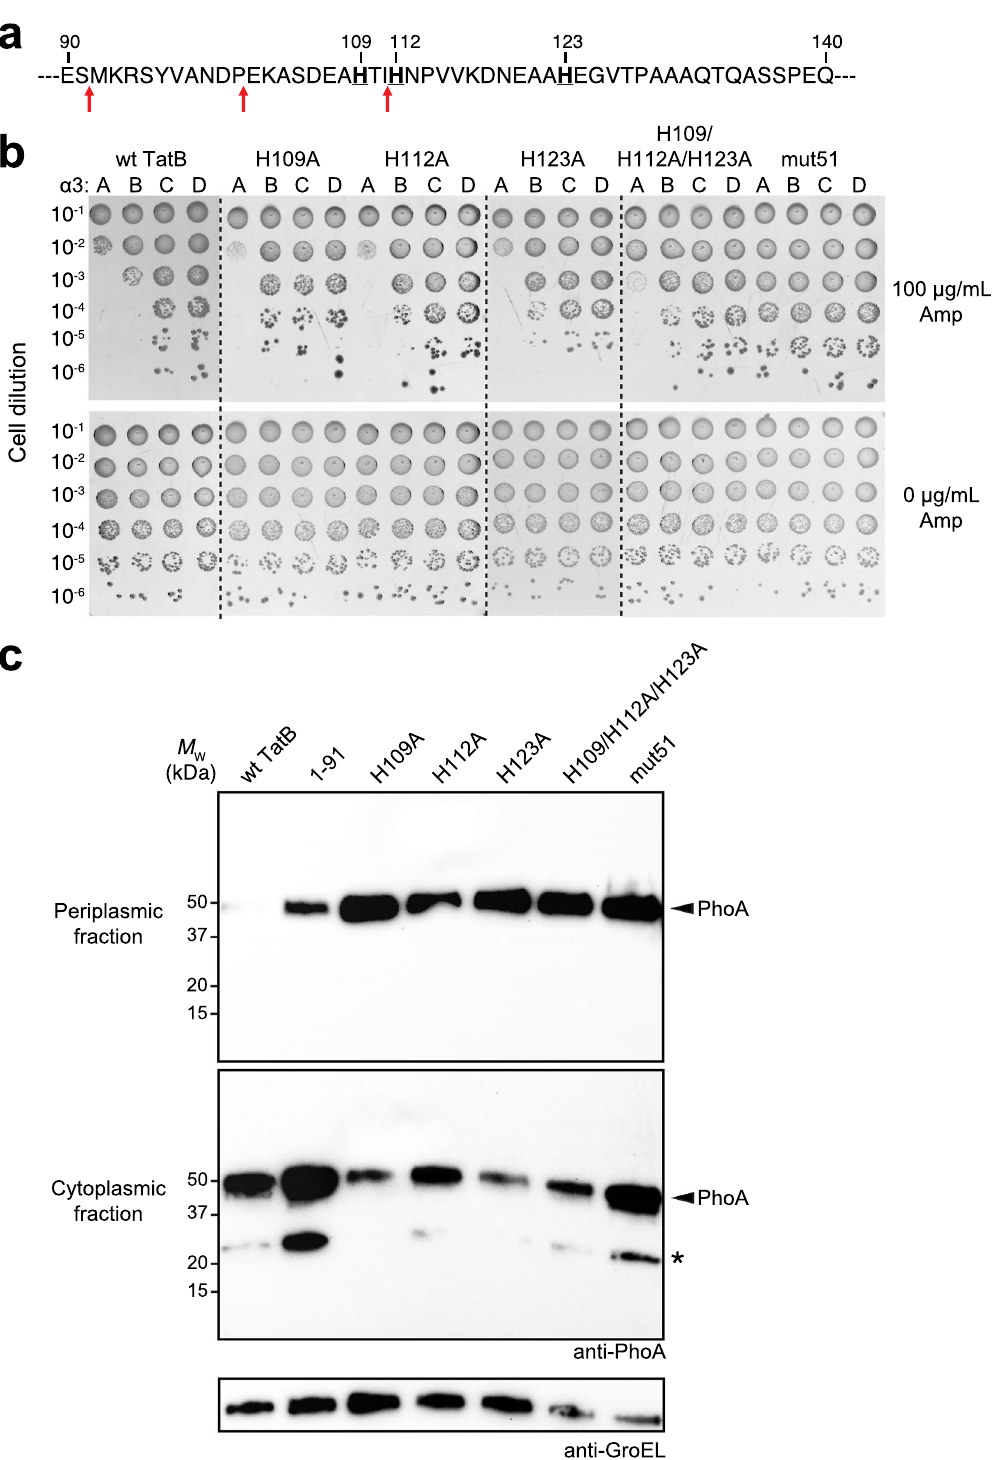
Figure 3. Histidine patch in membrane-extrinsic domain of TatB regulates folding QC. ( a ) Sequence of residues 90–140 of the membrane-extrinsic domain of TatB. Bold underline font denotes histidines at positions 109, 112, and 123; red arrows indicate QC-relevant truncation sites. ( b ) Serially diluted DADE cells co-expressing spTorA-α 3 -Bla chimeras (A, B, C or D) along with a Tat operon plasmid encoding wildtype (wt) TatB, one of the TatB variants, or the mut51 translocase were spotted on LB-agar plates containing either 100 μg/mL Amp or 25 μg/mL Cam (0 μg/mL Amp). Dashed lines denote different LB-agar plates that were all generated and imaged at the same time. ( c ) Western blot analysis of cytoplasmic and periplasmic fractions prepared from DADE cells co-expressing Tat-targeted PhoA from pTorA-AP along with either wt TatABC, mut51, or one of the histidine mutants as indicated. An equivalent number of cells was loaded in each lane. PhoA was probed with anti-PhoA antibody while anti-GroEL antibody confirmed equivalent loading in each lane. Asterisk indicates spTorA-PhoA breakdown product. Molecular weight ( M W ) markers are indicated on the left. Results are representative of three biological replicates. See Supplementary Fig. 1 for uncropped versions of the